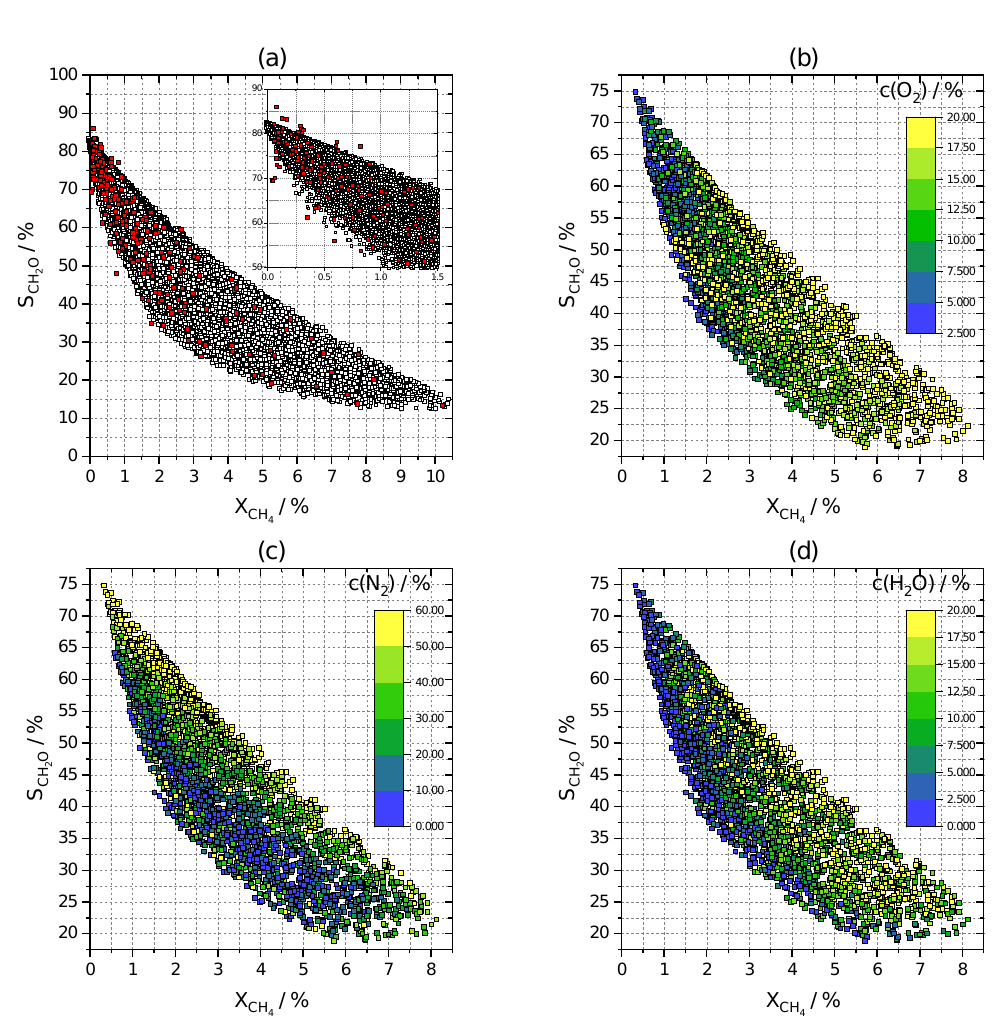
Figure 5. ( a ) Predicted selectivity and conversion over the whole input range (white) and training data (red). ( b – d ) Predicted selectivity and conversion at 660 ◦ C for the whole input range. Markers are colored by values of oxygen concentration ( b ), nitrogen dilution ( c ) or water cofeed ( d